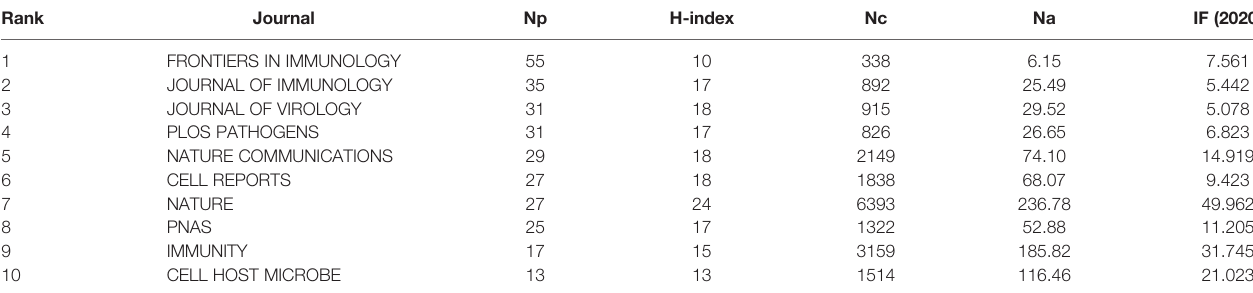
TABLE 3 | The top 10 productive